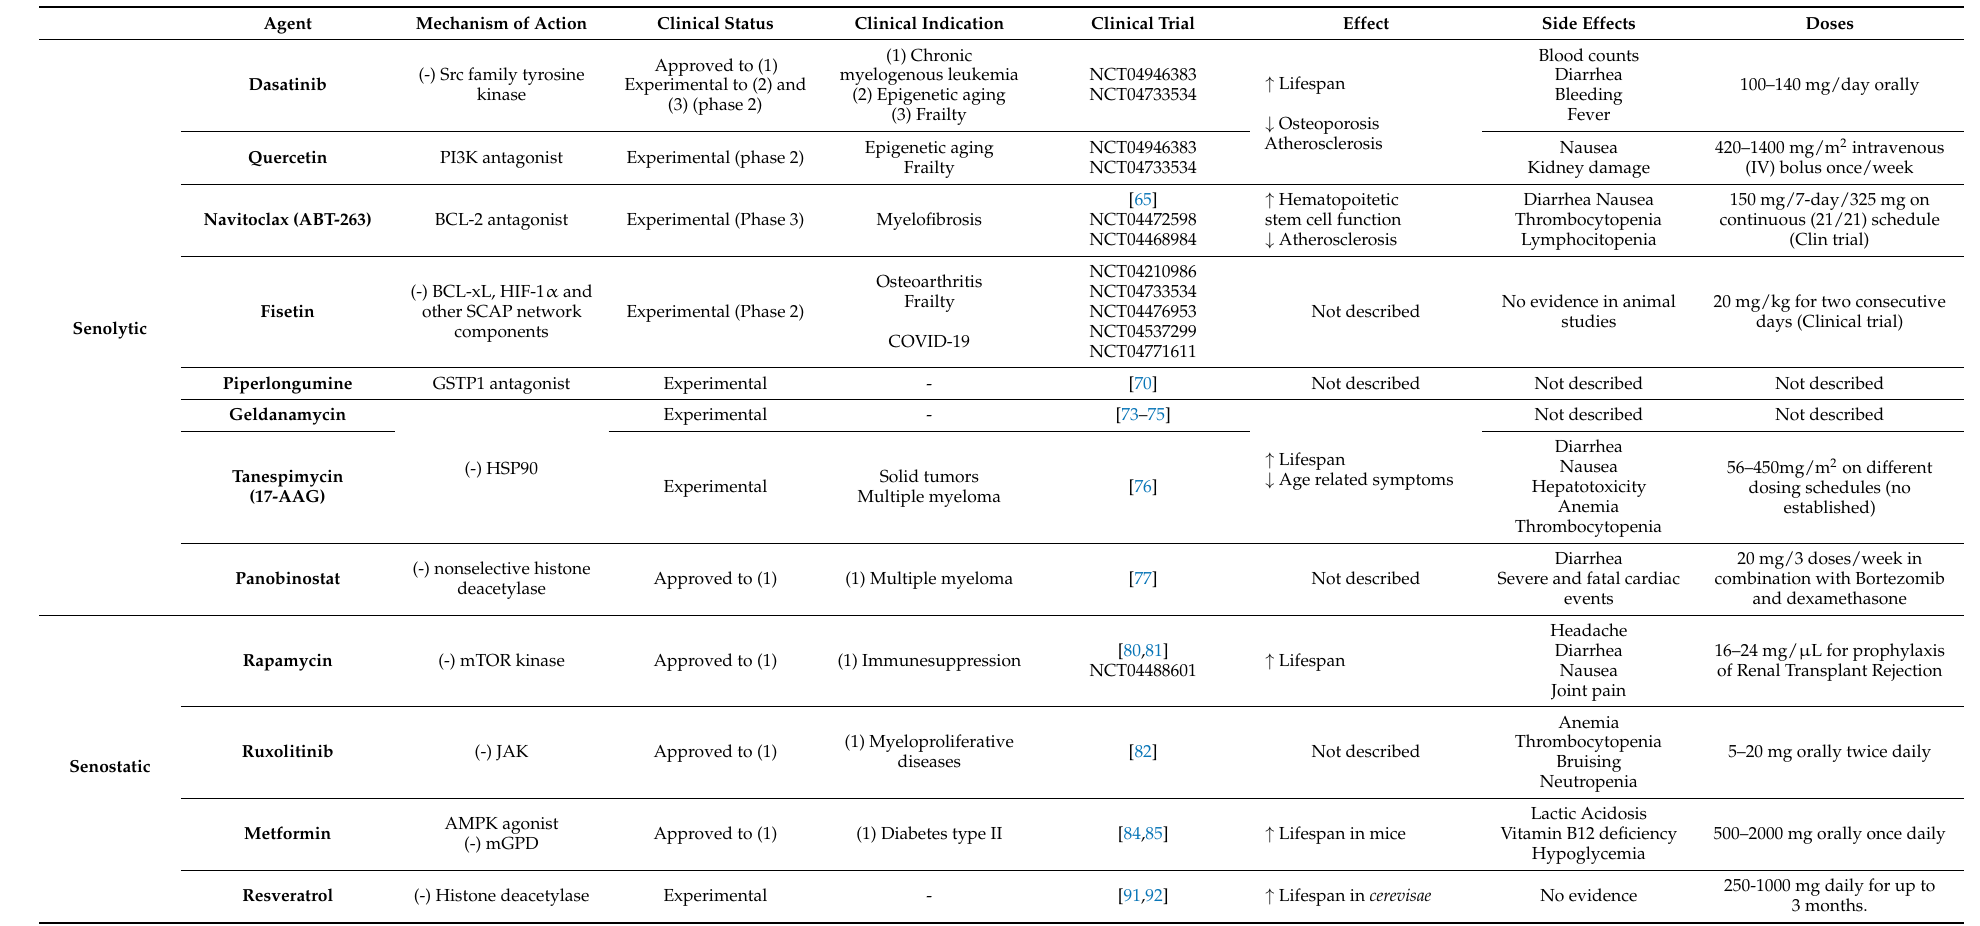
Table 2. Overview of